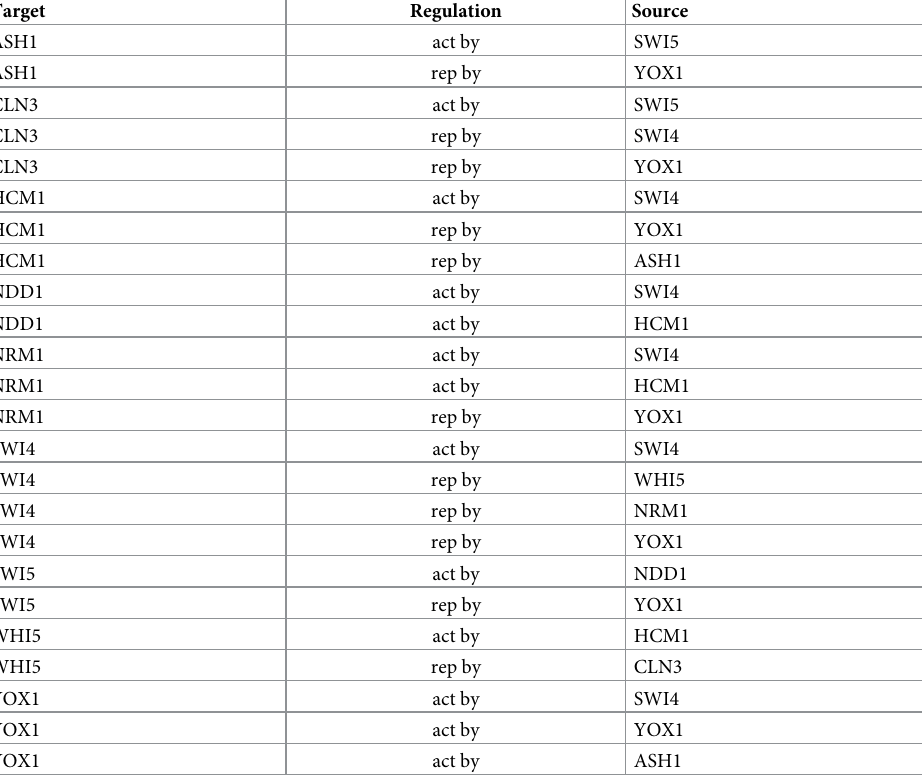
Table 6. Substantiated edges used in the yeast cell cycle results as determined from YEASTRACT and [35]. Every node acts both as a target and as a source. When annotations are specified, HCM1, NDD1, and SWI5 are activators only and NRM1, CLN3, and WHI5 are repressors only, as can be verified from the table. For example, HCM1 activates NDD1, NRM1, and WHI5, but has no repressing activity. All other nodes may be either activators or repressors.